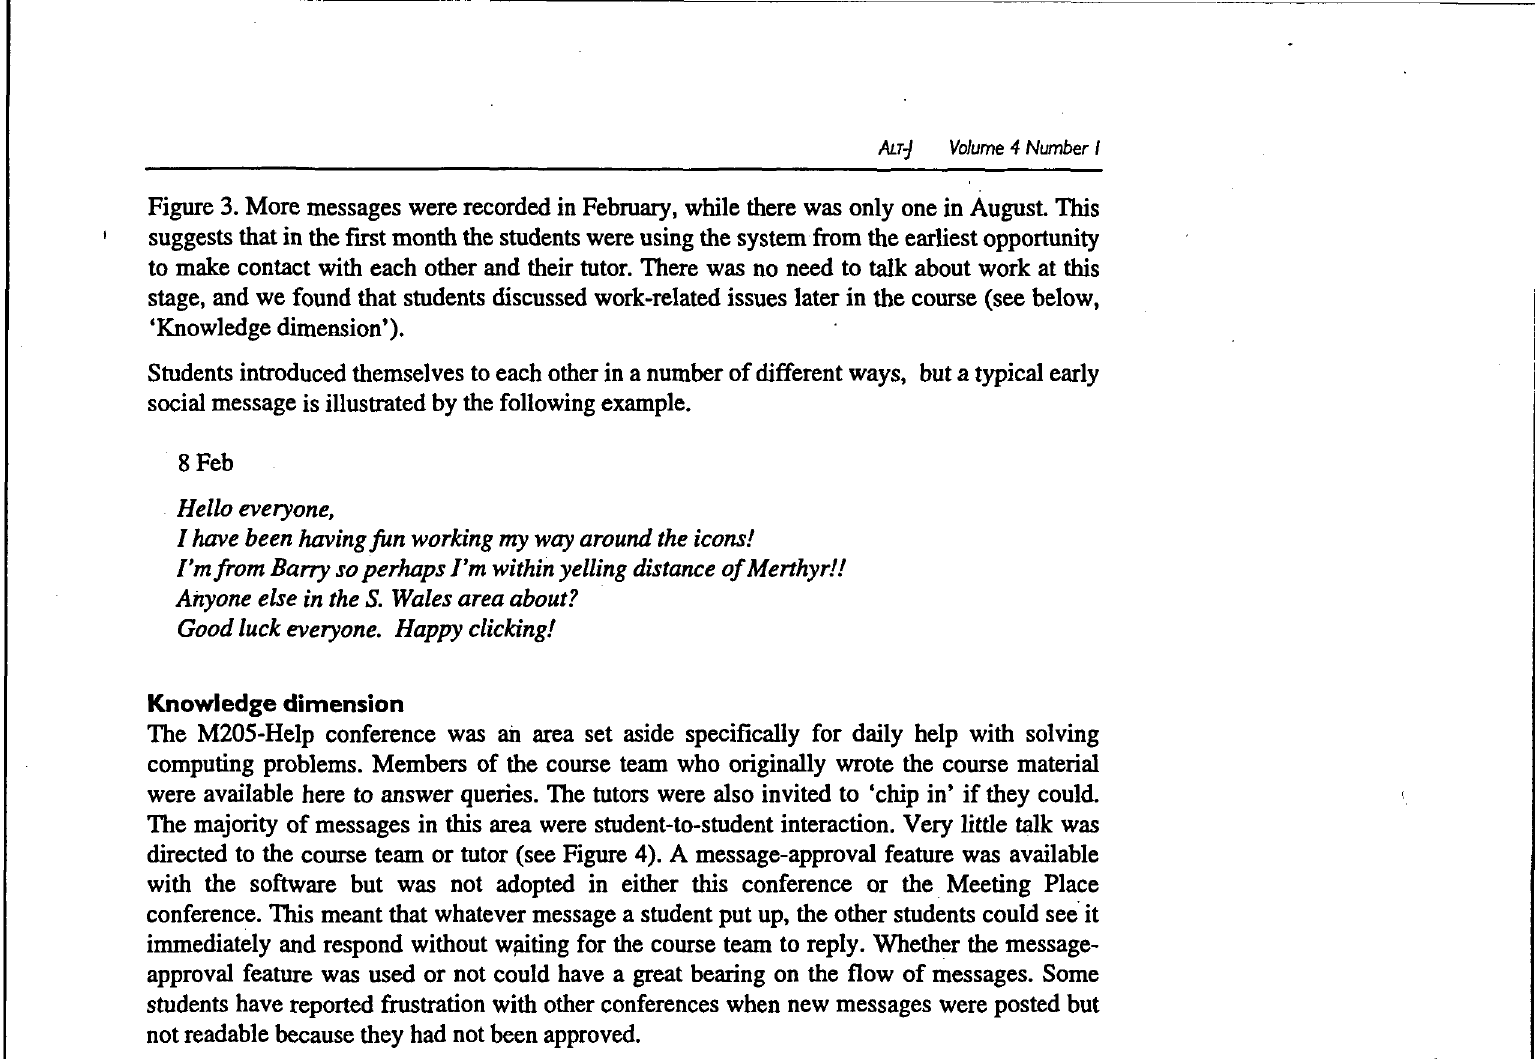
Figure 3. More messages were recorded in February, while there was only one in August This suggests that in the first month the students were using the system from the earliest opportunity to make contact with each other and their tutor. There was no need to talk about work at this stage, and we found that students discussed work-related issues later in the course (see below, 'Knowledge